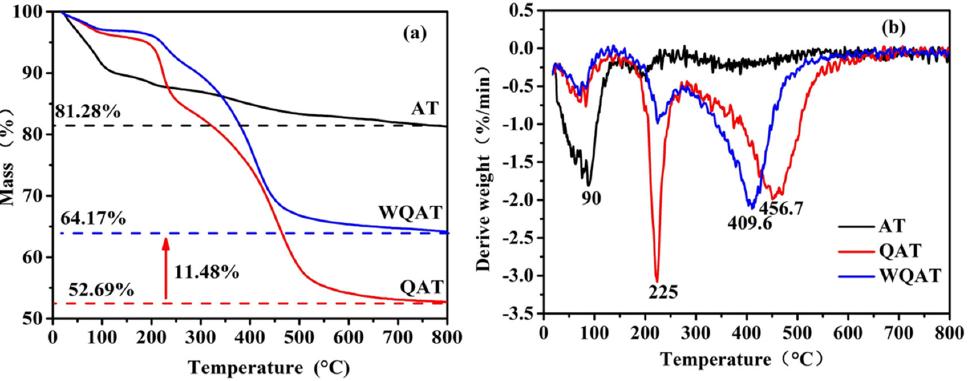
Figure 2. TGA ( a ) and DTG ( b ) curves of AT, QAT and WQAT.